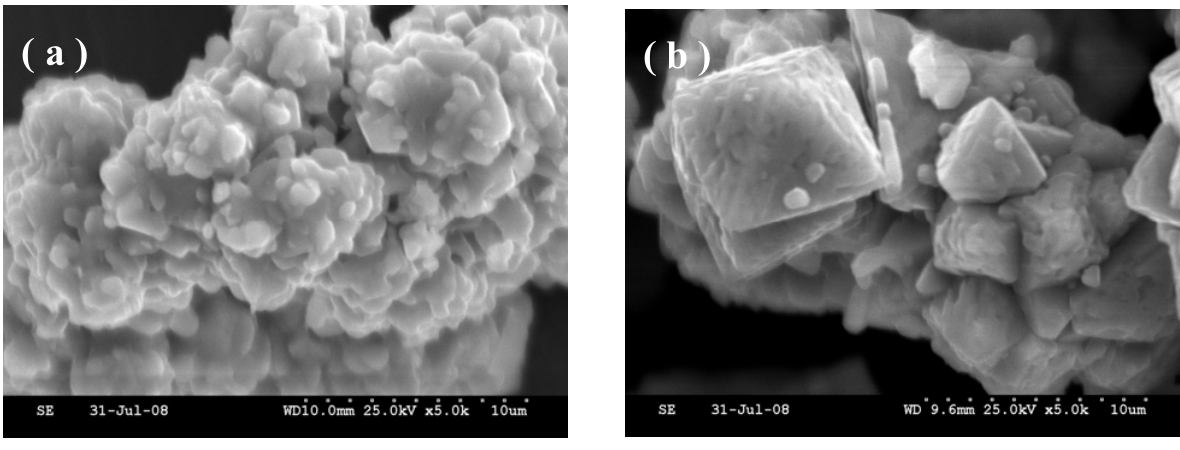
Figure 3. Scanning Electron Micrographs for HT-LiCoO 2 obtained by heating corresponding metal nitrates at 700 ° C in air for (a) 1 h and (b) 4